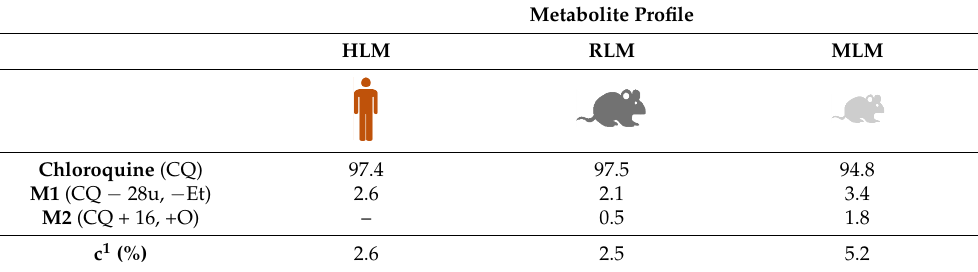
Table 1. Component analysis of human (HLM), rat (RLM) and mouse (MLM) liver microsomal-based metabolism of chloroquine. Each test was performed in triplicate, Stdr < 5%. Metabolite Profile HLM RLM MLM Chloroquine (CQ) 97.4